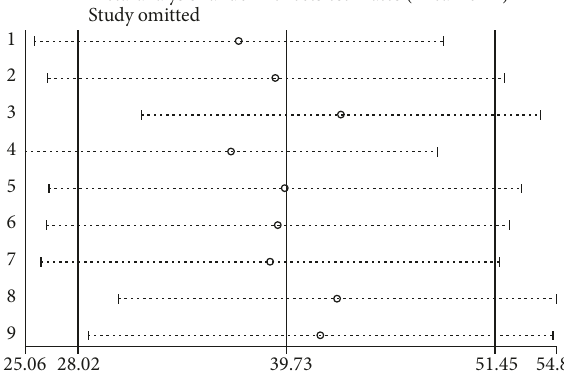
Figure 6: Result of Sensitivity analysis of the 9 studies, 2018. unduly influenced the overall prevalence estimate of depres- sion among patients with diabetes (Figure